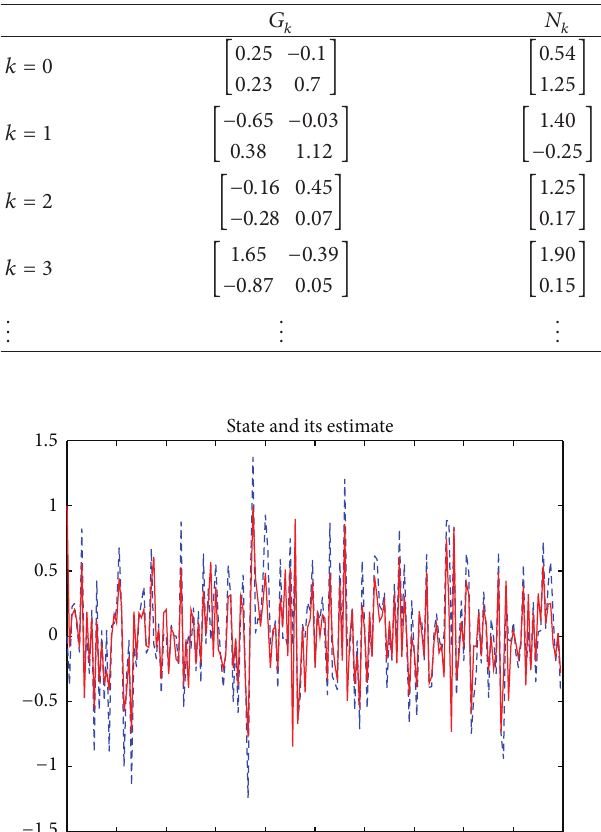
Table 1: The filter parameters.